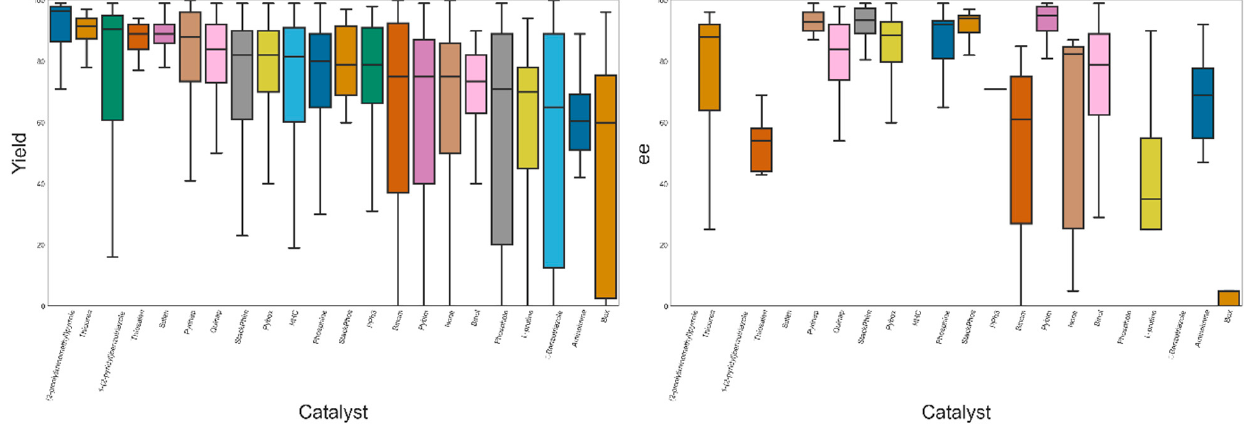
Figure 9. ( left ) Yields of ligands with more than 25 entries. ( right ) ee of ligands with more than 25 entries.